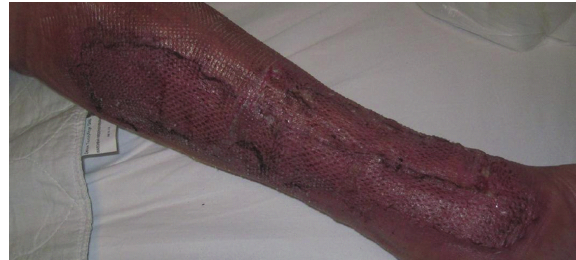
Figure 4: Wound appearance 7 days after split-thickness skin grafts and treatment with a light vacuum dressing to stabilize the skin grafts. A cosmetically acceptable result has been achieved, without functional